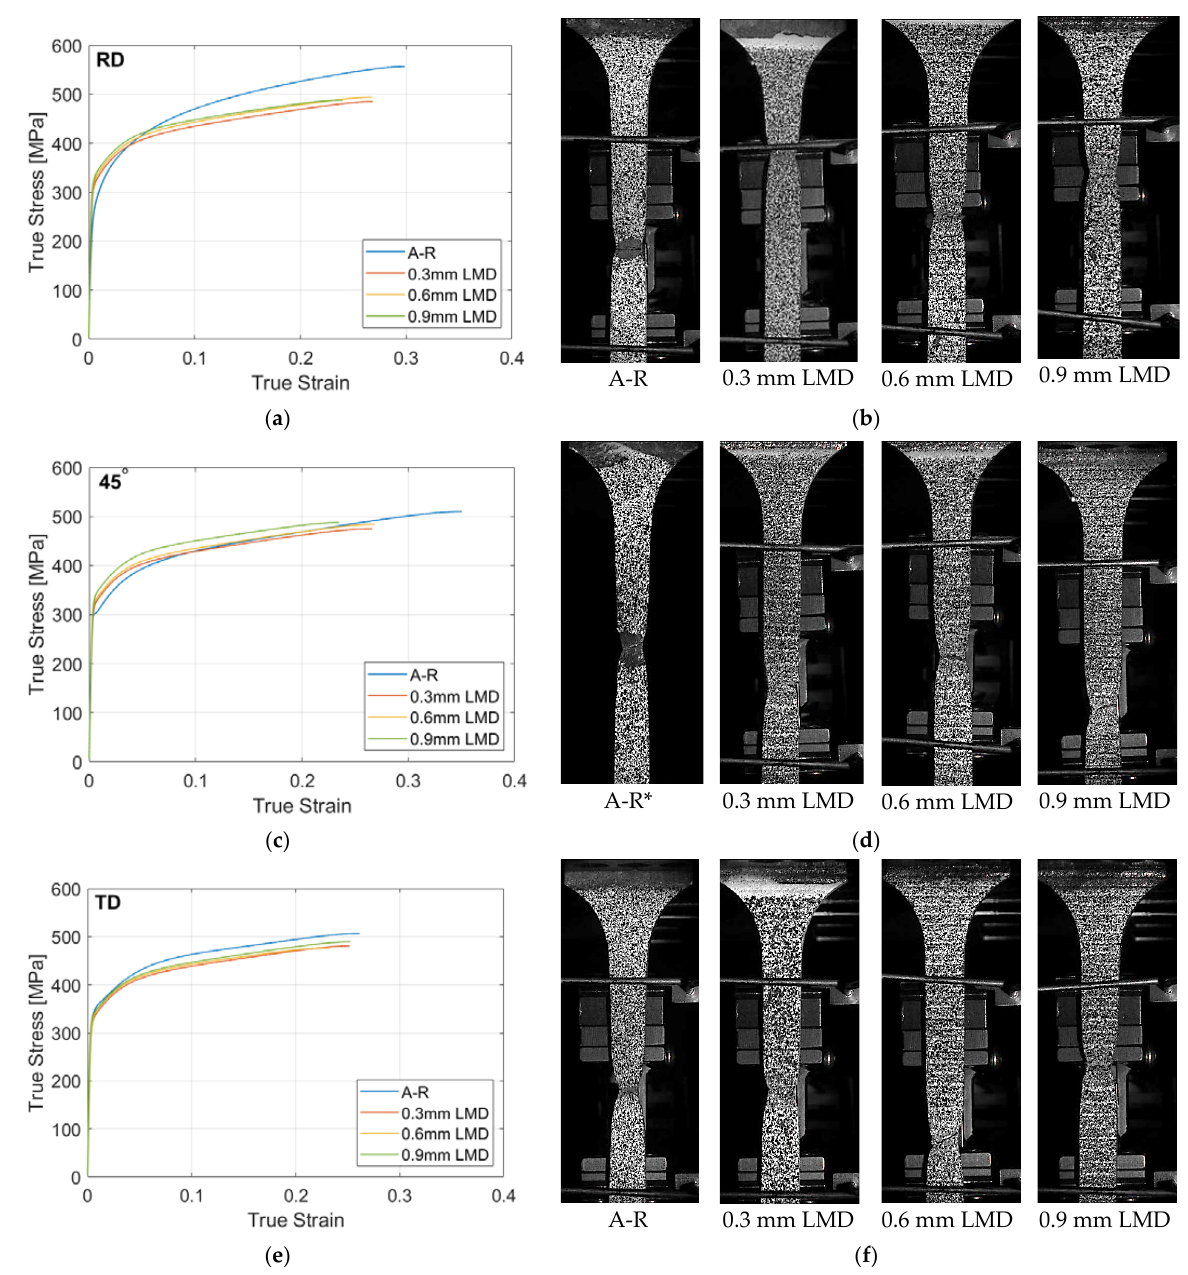
Figure 11. Results of uniaxial tensile testing: ( a ) True stress ( α ) vs. strain ( ε ) curves in the sheet RD; ( b ) RD tensile specimens at fracture; ( c ) True α vs. ε curves in the diagonal direction (45 ◦ ); ( d ) 45 ◦ diagonal tensile specimens at fracture * Extensometer was removed due to amount of elongation and plot was calculated from raw strain data; ( f ) True α vs. ε curves in the TD direction; ( e ) TD tensile specimens at